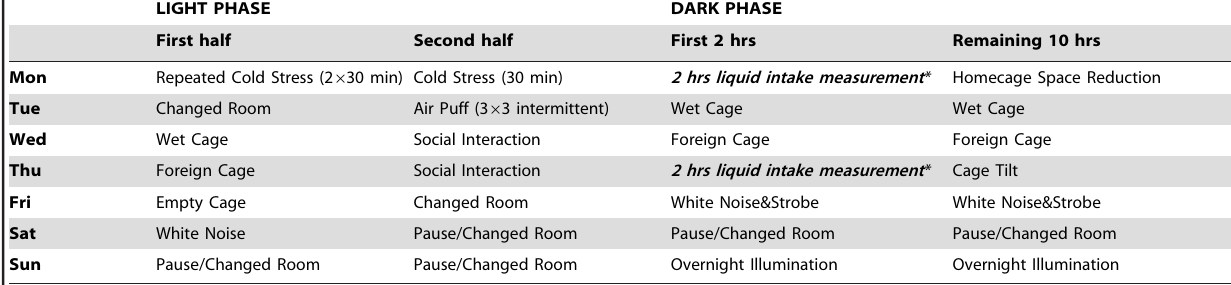
Table 1. Weekly CMS